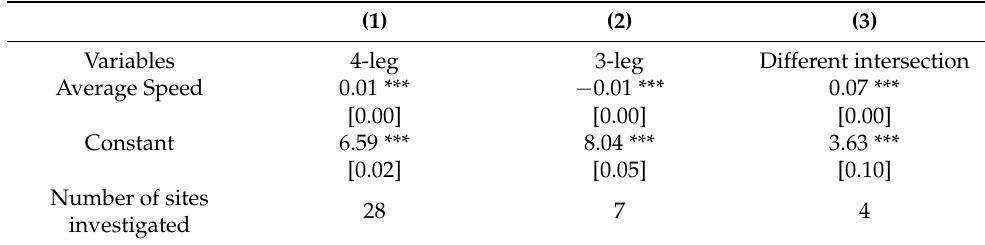
Table 6. Relationship between red light violation with speed with crashes.